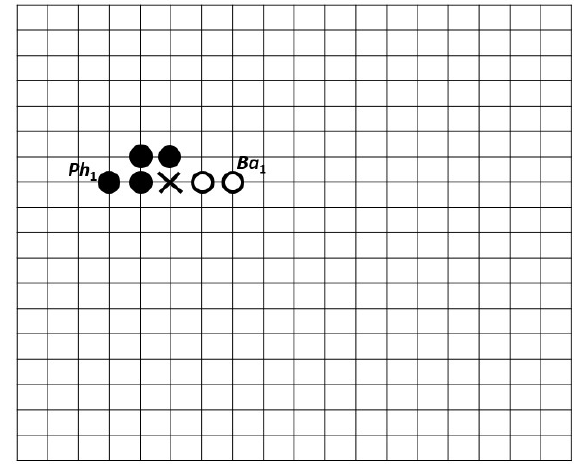
Figure 2: An illustrative configuration of the